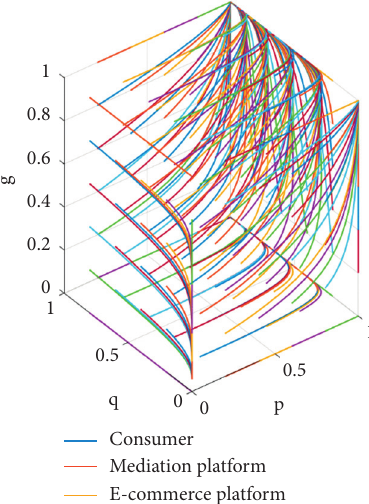
Figure 8: Influence of strategy choice of game subjects.